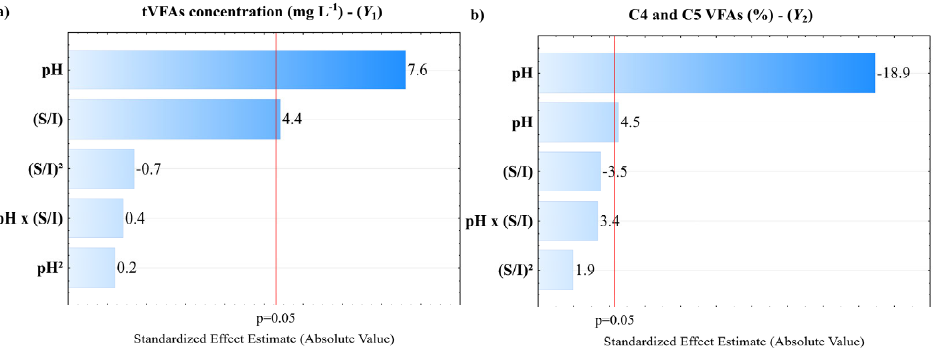
Figure 2. Pareto chart of the standardized effects for the substrate to inoculum ( S/I ) ratio, pH , and their interaction on ( a ) total VFAs concentration ( Y 1 , mg L − 1 ) and ( b ) amount of C4 and C5 VFAs yielded during anaerobic production of organic acids from olive mill solid waste ( Y 2 , %).